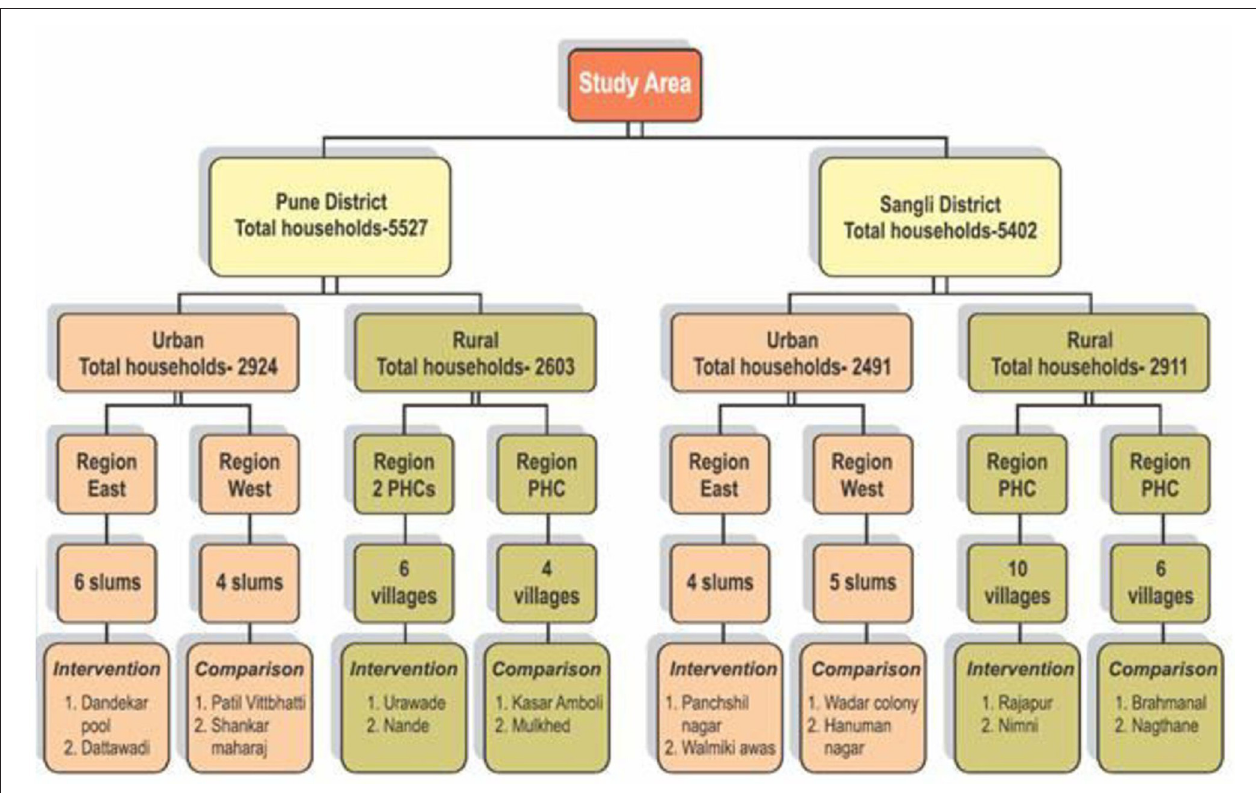
FIGURE 1 | Study area and selection of